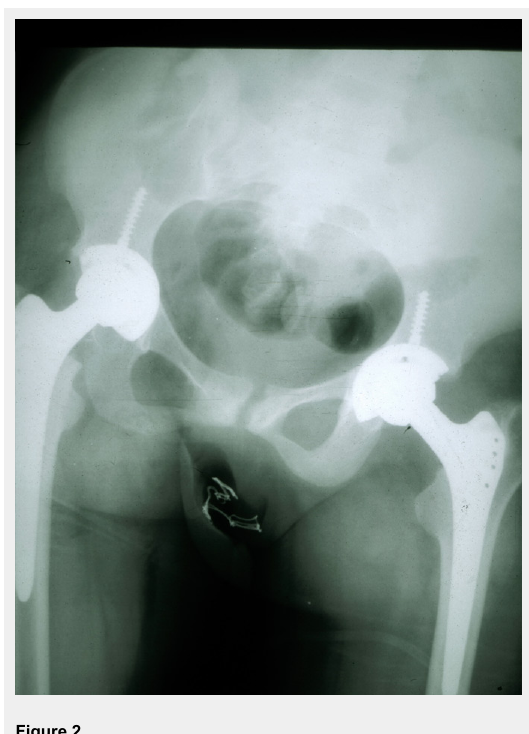
Hip replacement in a patient with